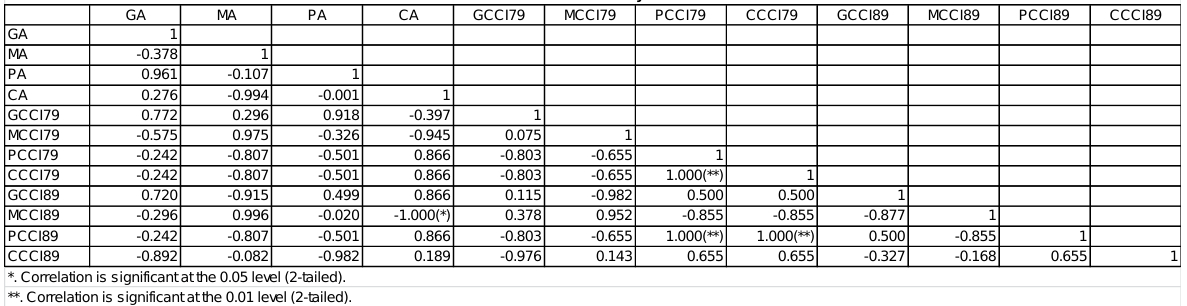
Figure 4. Pearson correlation test results for the first year for total anthocyanin from the grapes vs. the total chlorophyll content in the leaves (G, M, P, and C correspond with the four studied varieties Gelu, Moldova, Purpuriu, and Coarna neagra , respectively, GA, MA, PA, CA are the anthocyanin concentrations, GCCl79, MCCl79, PCCl79, CCCl79 are the chlorophyll concentrations for the four varieties corresponding with the BBCH phase 79, while GCCl89, MCCl89, PCCl89, and CCCl89 are the chlorophyll concentrations for the corresponding varieties in the BBCH — 89 phase).